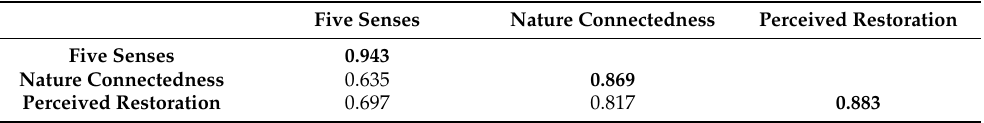
Table 2. Discriminant validity of the